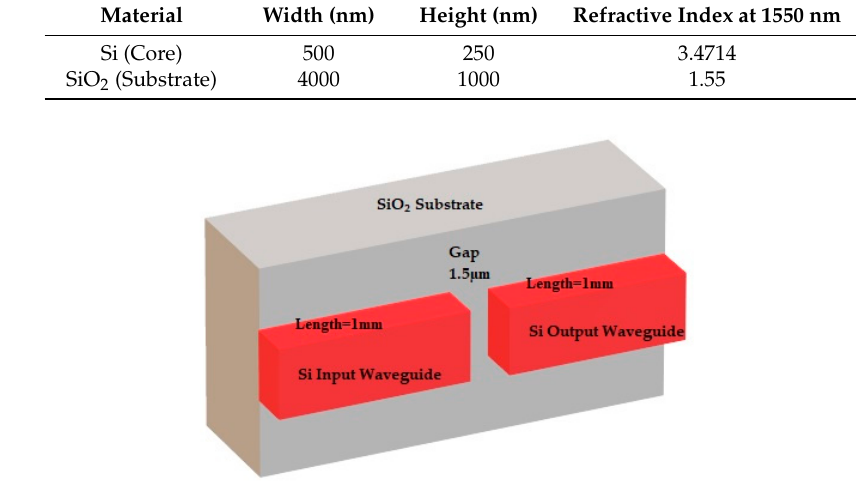
Figure 6. Waveguide geometry.